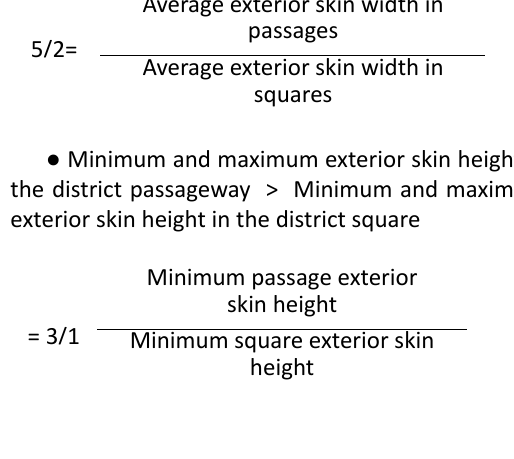
The average height of the district